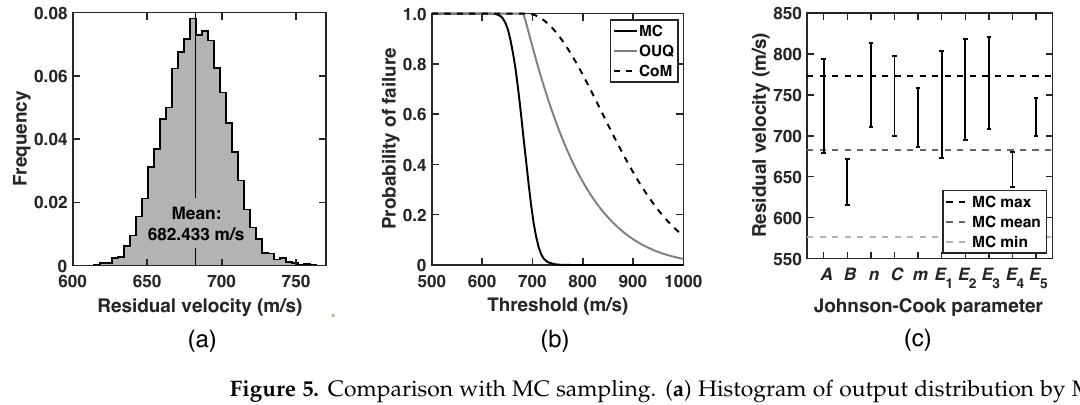
Figure 5. Comparison with MC sampling. ( a ) Histogram of output distribution by MC sampling. ( b ) Probability of failure computed from direct MC sampling and bounded by OUQ and CoM. ( c ) Residual velocities at the bounds of sub-diameters. In subfigure ( c ), the mean, maximum and minimum values of sampling results by MC are also shown.